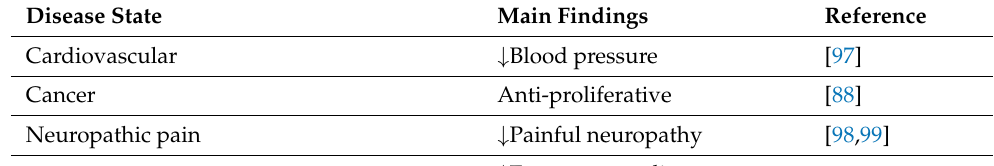
Table 1. Summary of studies outlining the effects of capsaicin on chronic disease states. Disease